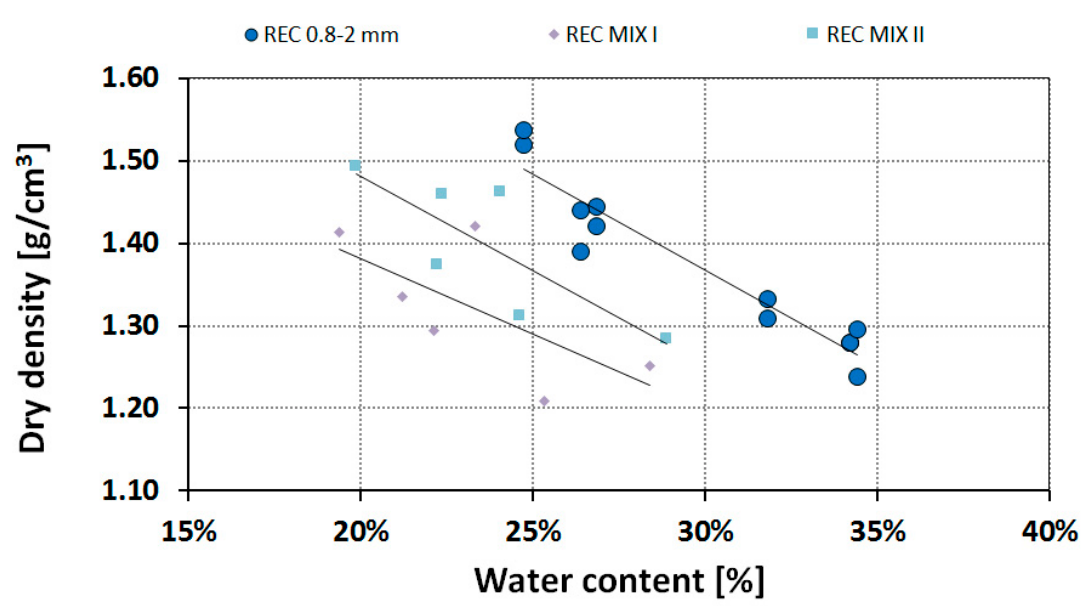
Figure 7. Graph showing the results of the evaluation of dry density depending on the water content of the sprayed Bentonite 75 (comparison of three mixtures tested in this